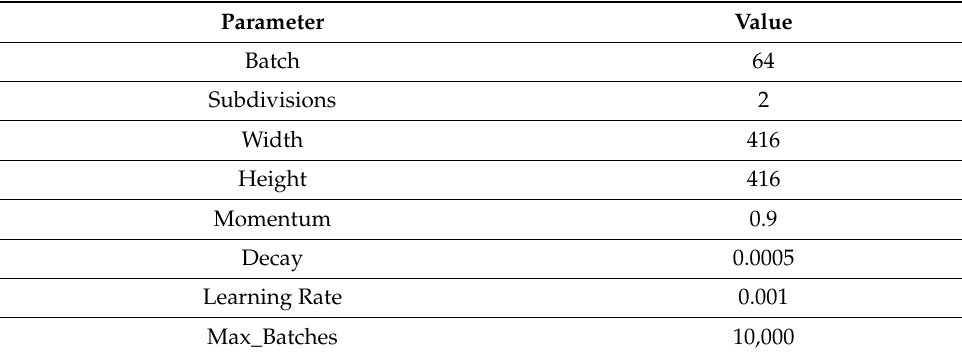
Table 3. Parameter of Tiny-YOLOv3 at learning.